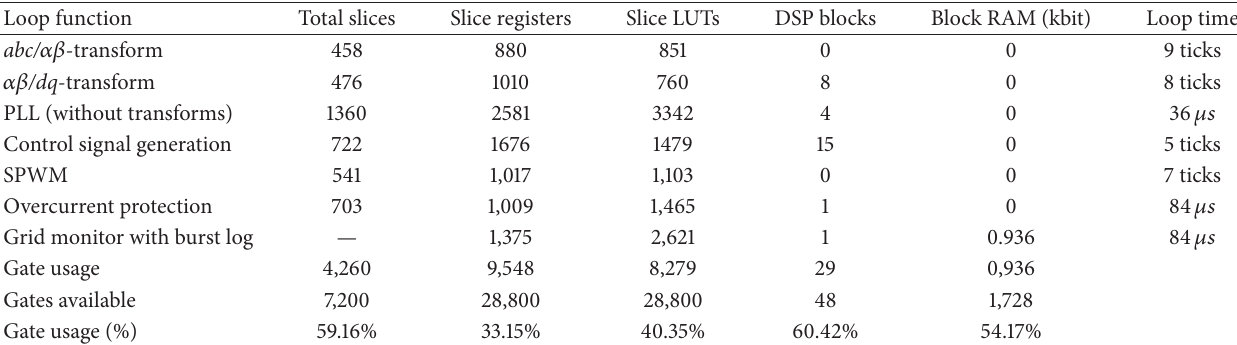
Figure 5: (a) Three-phase inverter with driver circuits mounted on top. (b) The compactRIO-based control system. Table 4: FPGA gate utilization for various implemented